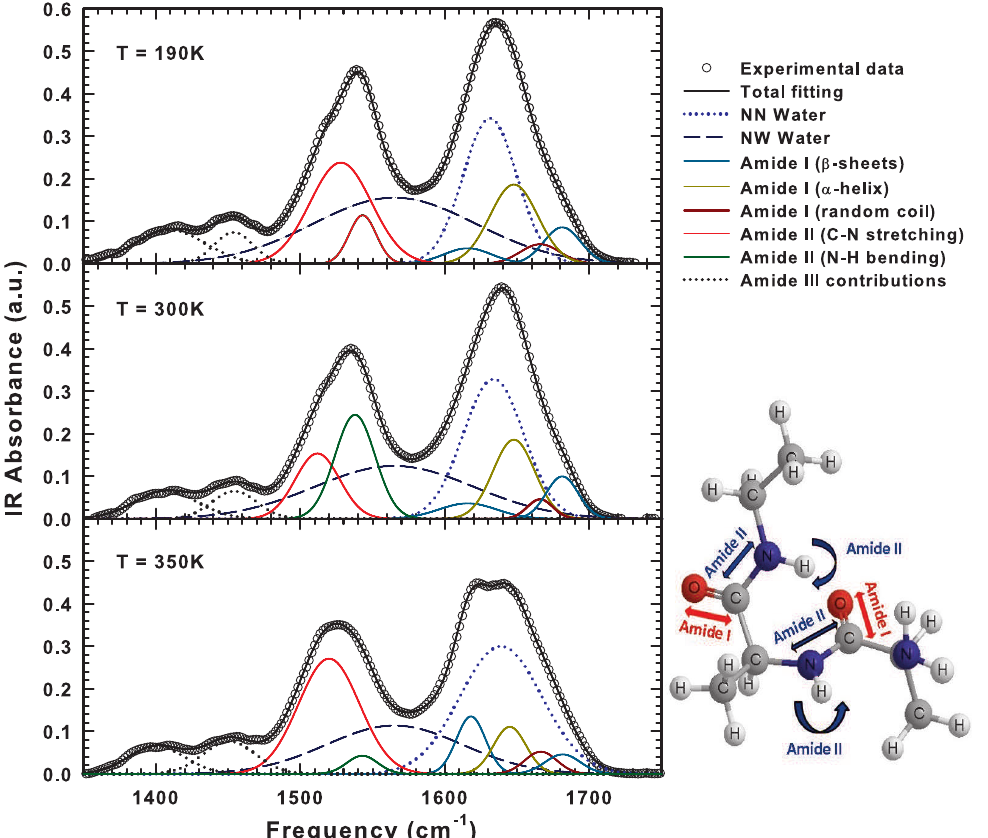
Figure 7. The Gaussian deconvolution of the recorded FTIR spectra for hydrated lysozyme with h = 0.3, at three different temperatures. We illustrate the case of T = 190 K (glassy state), T = 300 K (native state) and T = 350 K (irreversible denaturation). On the bottom right a schematic representation of the Amide I and II vibrational modes is shown. Figure adapted from Reference